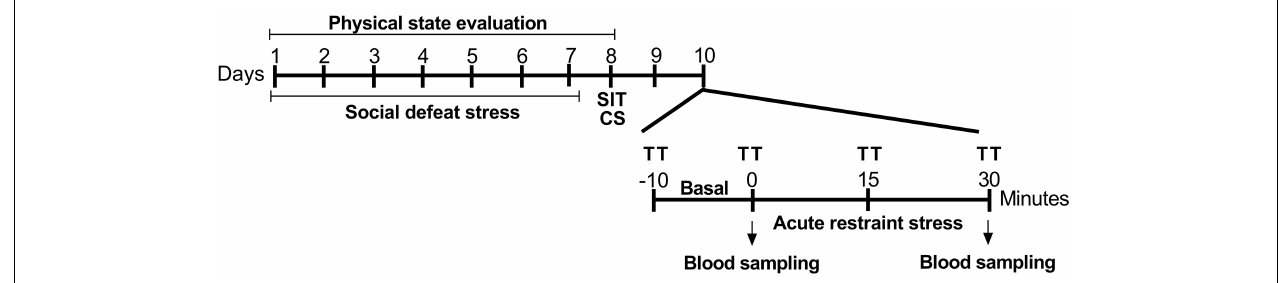
FIGURE 1 | Experimental procedure timeline. SDS was performed on alternative days for 7 days, for a total of four aggressive encounters. After 24 h, stress coping phenotypes were identified using the social interaction test. After the phenotyping, animals were cannulated to the recording of cardiovascular parameters during restraint stress. SDS, social defeat stress; SIT, social interaction test; CS, cannulation surgery; TT, cutaneous tail temperature.